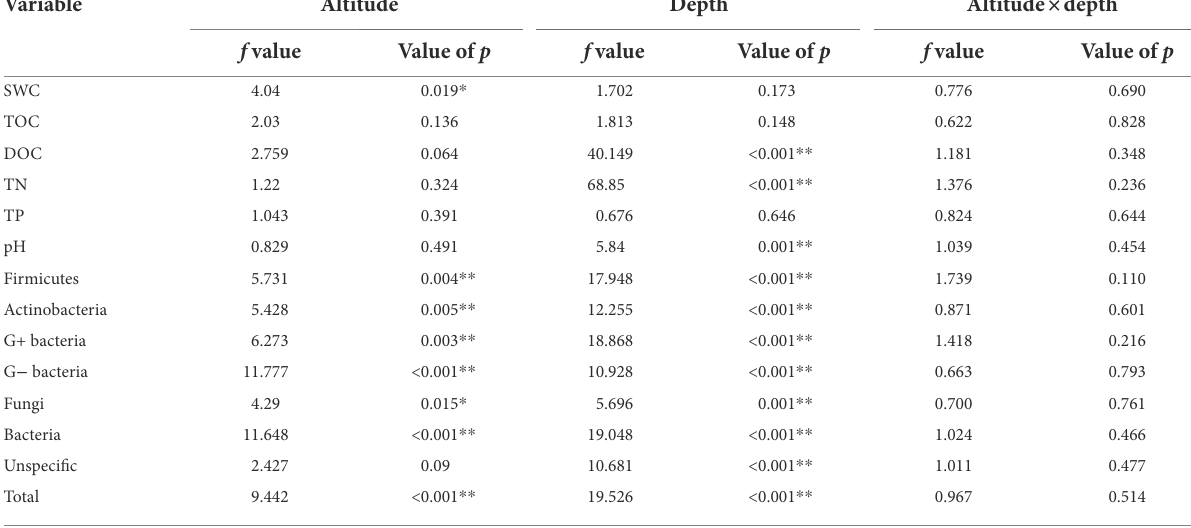
TABLE 1 A summary of analysis of variance (ANOVA) on the effects of altitude and soil depth for soil physicochemical properties and microbial groups.